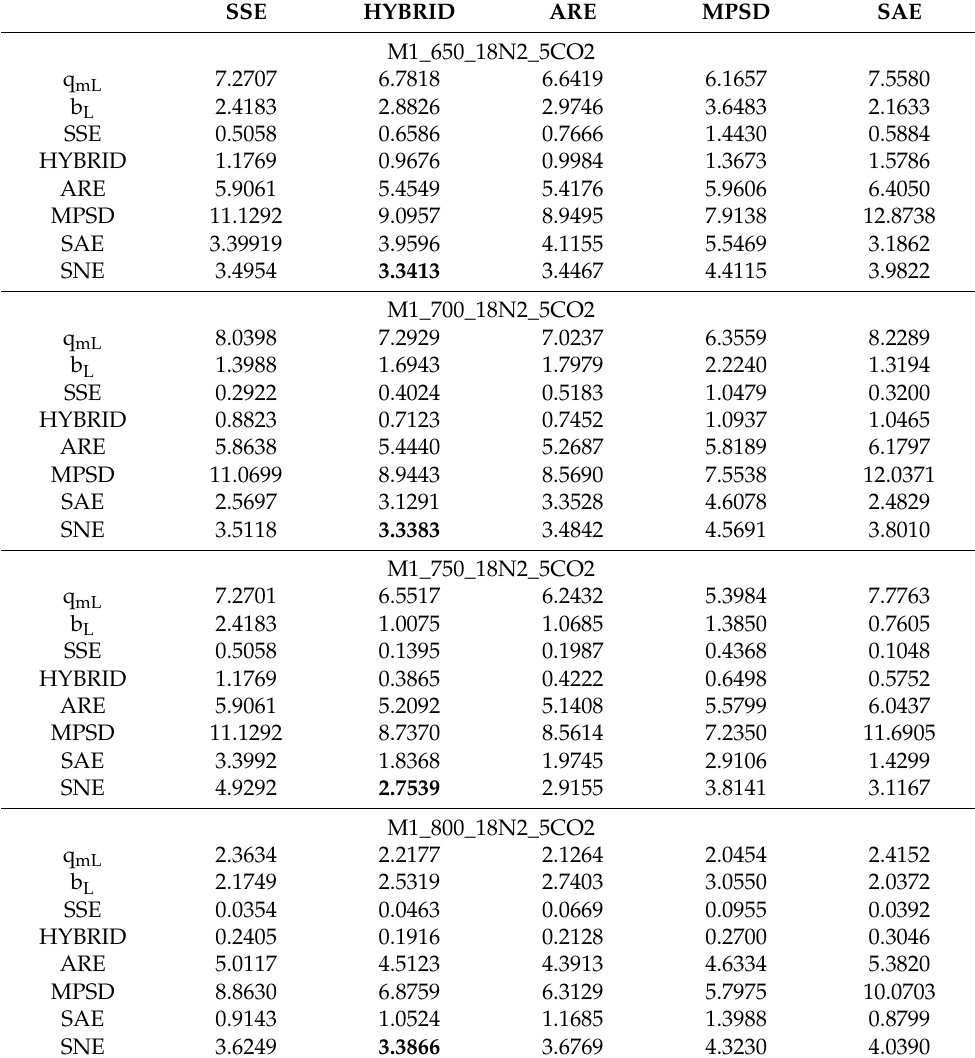
Table 3. Langmuir isotherms constants with error analysis